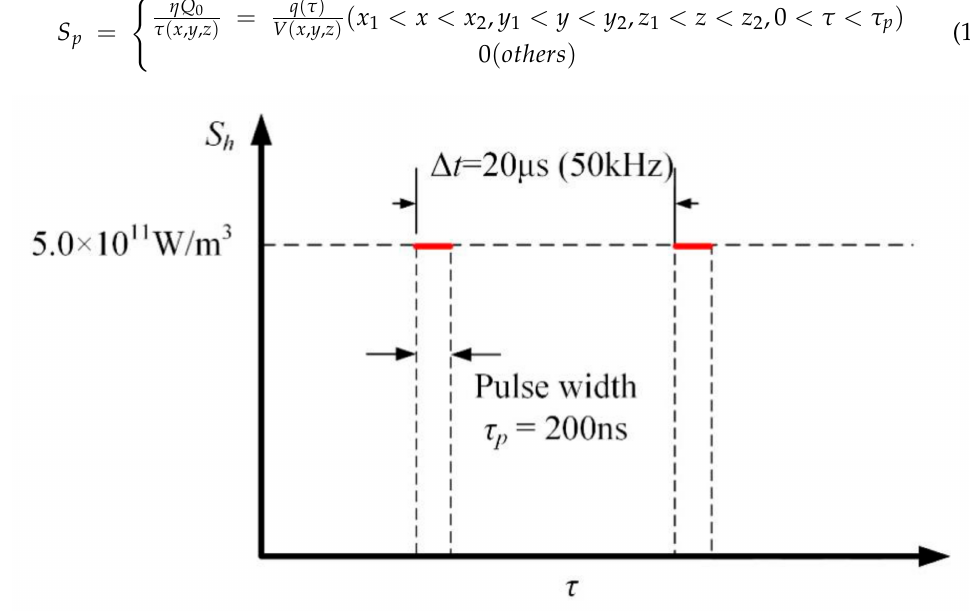
Figure 3. Diagram of arrayed pulsed energy